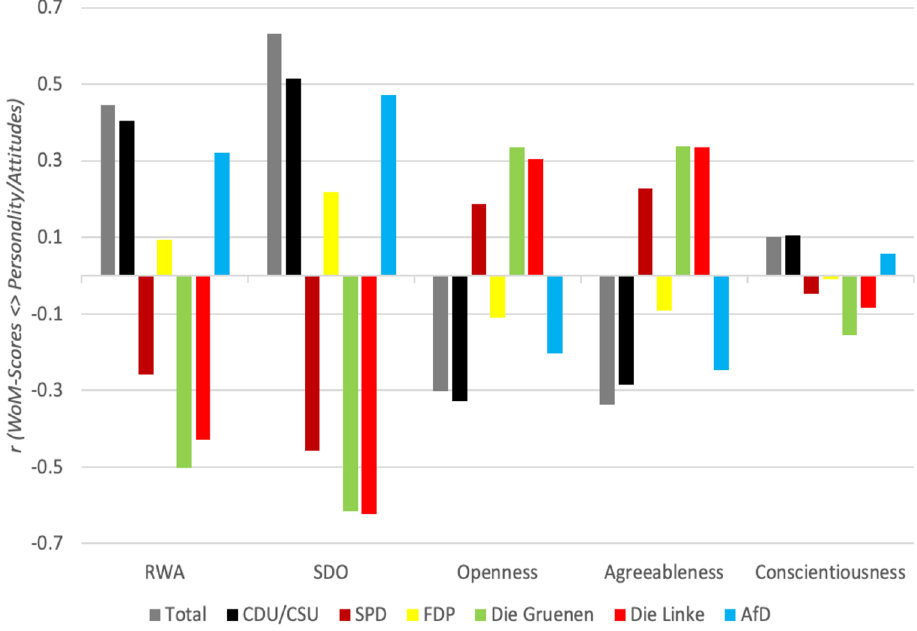
Figure 2. Correlations between individual WoM- and trait- scores across international samples. * p < .05. ** p < .01. *** p <